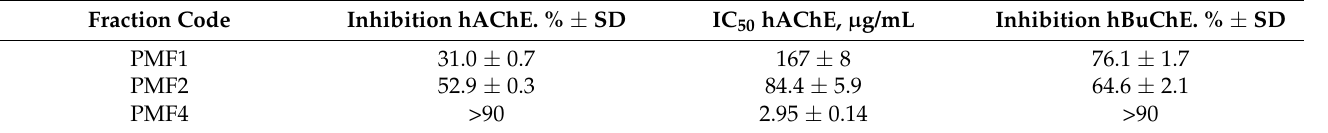
Table 3. Anticholinesterase activity of active fractions achieved by flash chromatography. Fraction Code Inhibition hAChE. % ± SD